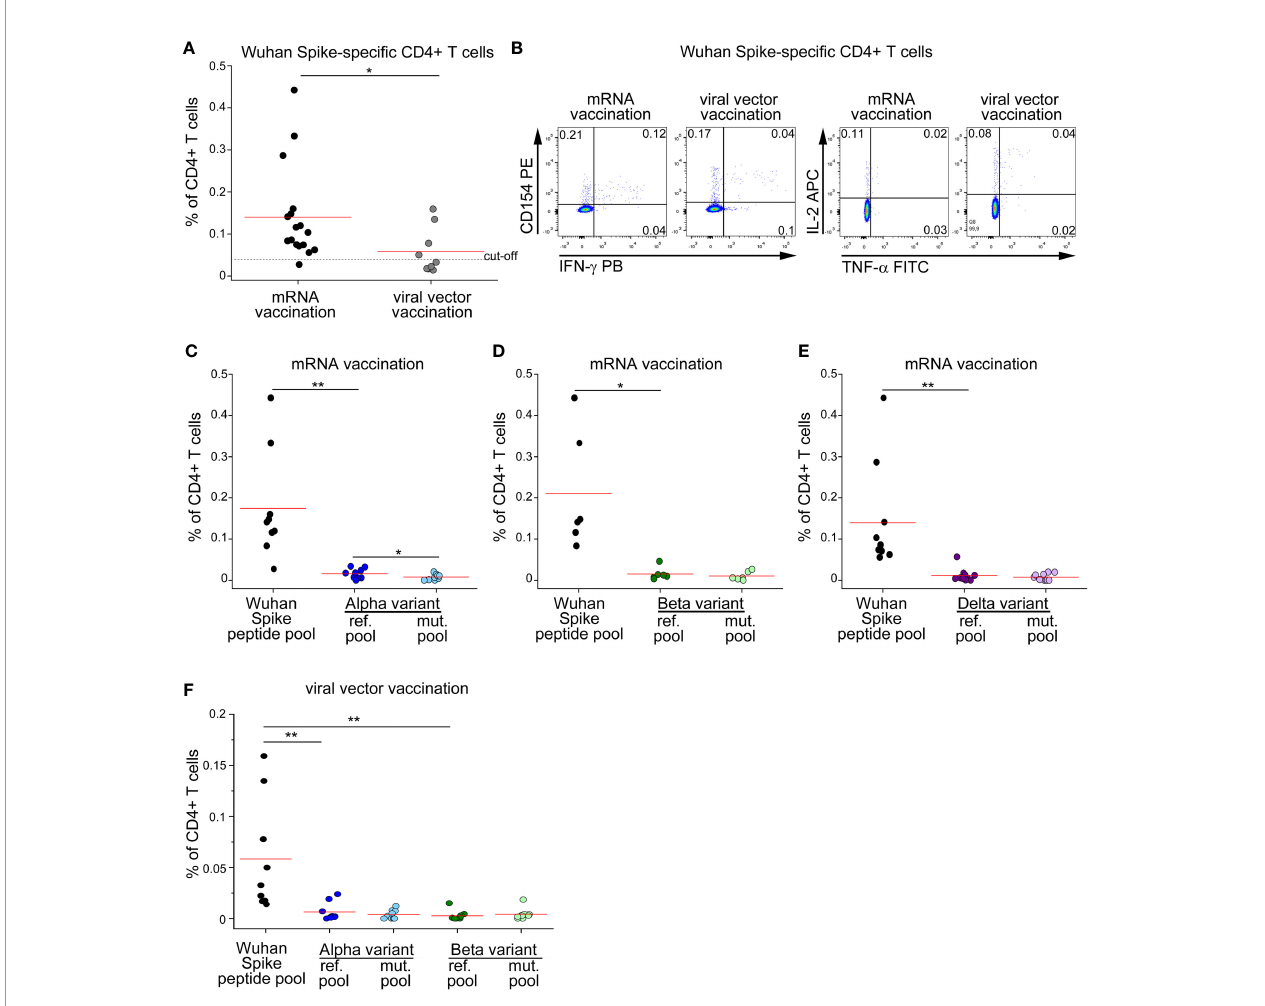
FIGURE 2 | CD4+ T cell response to Spike in vaccinated subjects is minimally affected by mutations occurring in Alpha, Beta and Delta variants. (A) Frequency of CD4+ T cells speci fi c for Wuhan Spike protein in mRNA- (17) or viral vector- (9) vaccinated subjects. Representative FACS plot are depicted in (B) . Frequency of CD4+ T cells speci fi c for Wuhan Spike, Alpha variant reference or mutated pool (C) , Beta variant reference or mutated pool (D) , Delta variant reference or mutated pool (E) in 9, 6 and 10 mRNA-vaccinated subjects, respectively. (F) Frequency of CD4+ T cells speci fi c for Wuhan Spike, Alpha variant reference or mutated pool, Beta variant reference or mutated pool in 9 subjects with viral vector vaccination. Data in (A, C – F) are subtracted of background, unstimulated condition. Red lines in (A, C – F) represent mean values. Dashed line in (A) represents cut-off value. *p < 0.05; **p < 0.01, calculated with Mann-Whitney test (A) or Wilcoxon-Signed Rank test (C – F)